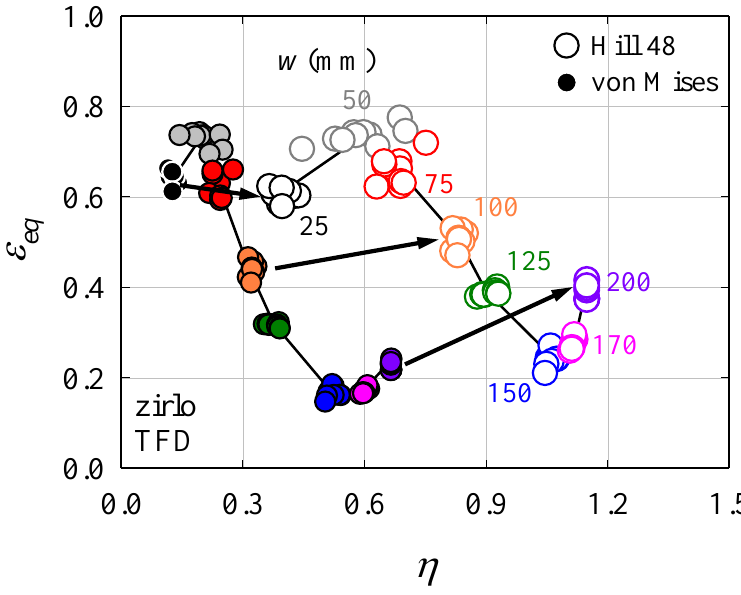
Figure 9. Influence of r when converting FLD data to triaxiality failure diagram (TFD).